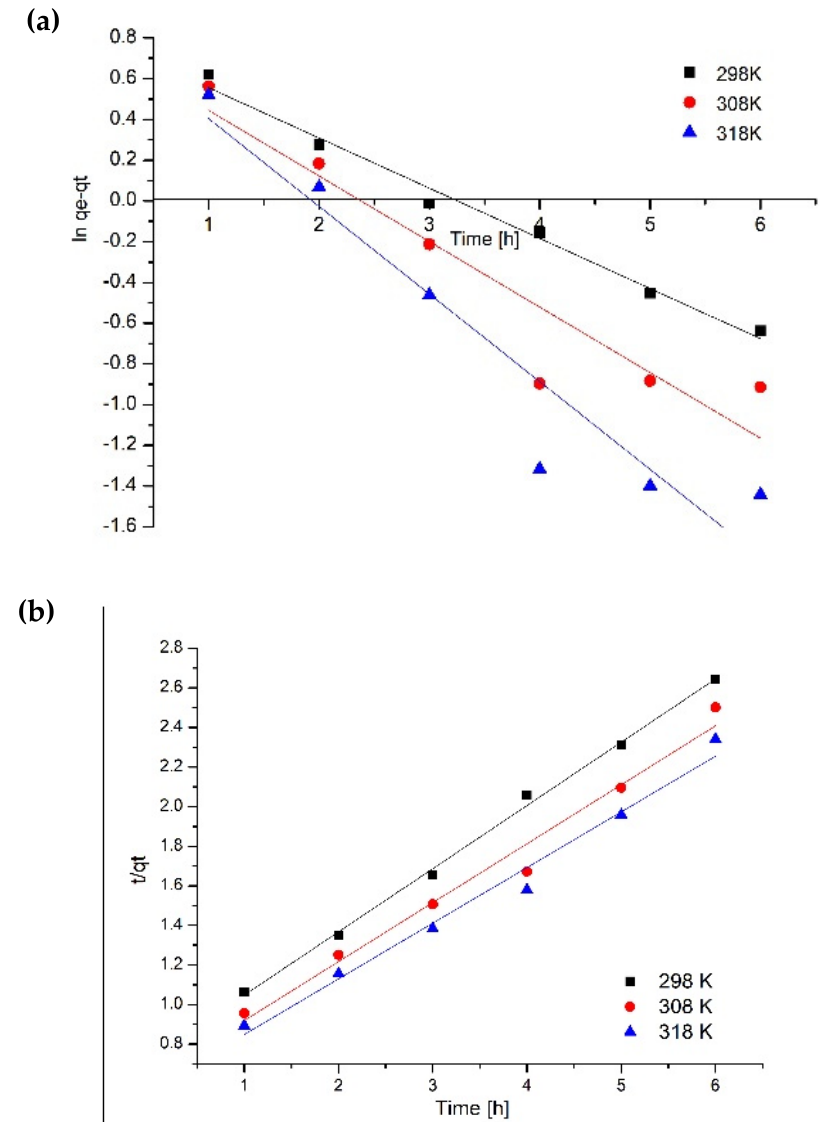
Figure 9. Kinetic studies. ( a ) pseudo-first-order; ( b )